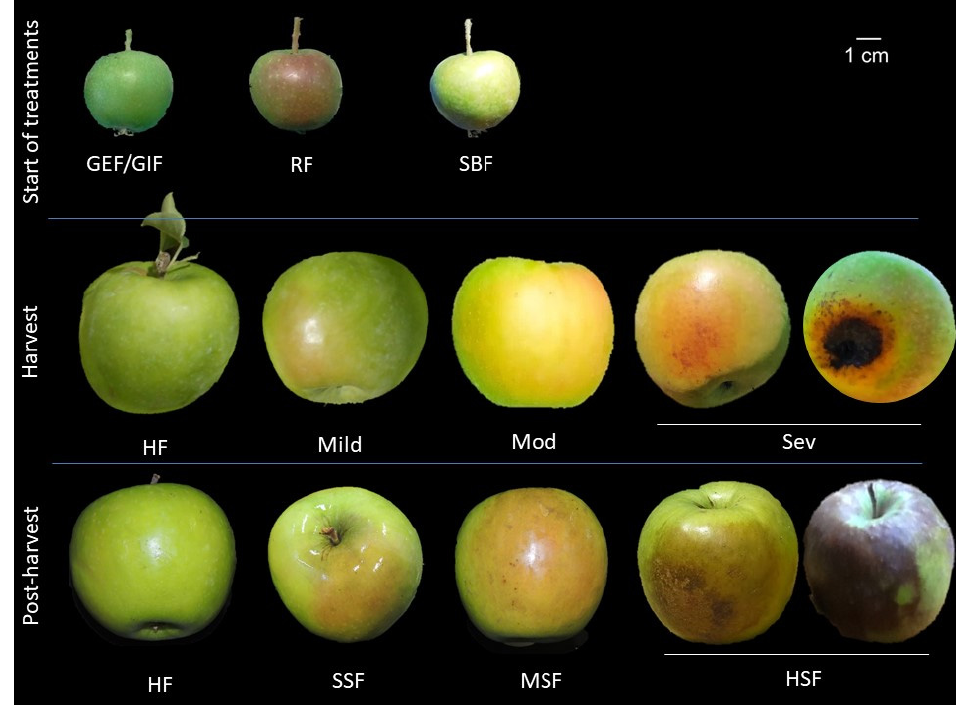
Figure 1. Examples of fruit categories at three stages of damage development. At the beginning of treatments (6 WAFB = weeks after full bloom): RF = red fruit, GEF = green external fruit, GIF = green internal fruit, and SBF = sunburned fruit. At harvest: HF = healthy fruit, Mild = slightly sunburned fruit, Mod = moderately sunburned fruit, Sev = heavily sunburned fruit; and Post-harvest: HF = healthy fruit, SSF = slightly sunscalded fruit, MSF = moderately sunscalded fruit, HSF = heavily sunscalded fruit.